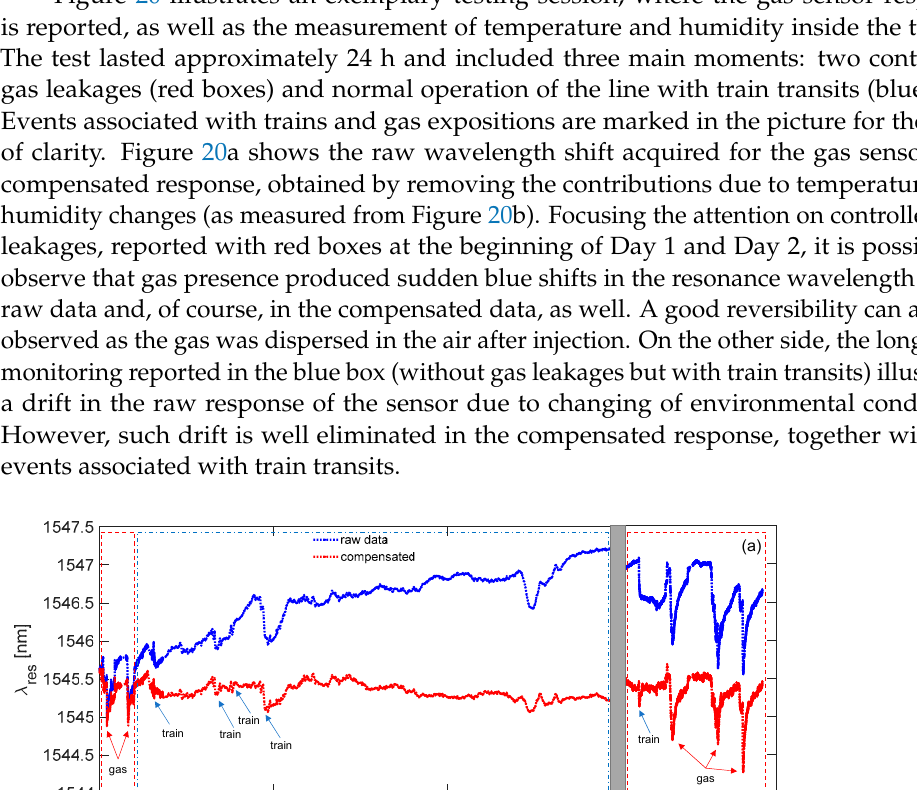
Figure 19. Schematic illustration and pictures of the gas monitoring system for railway tunnel. (Adapted from [147]).